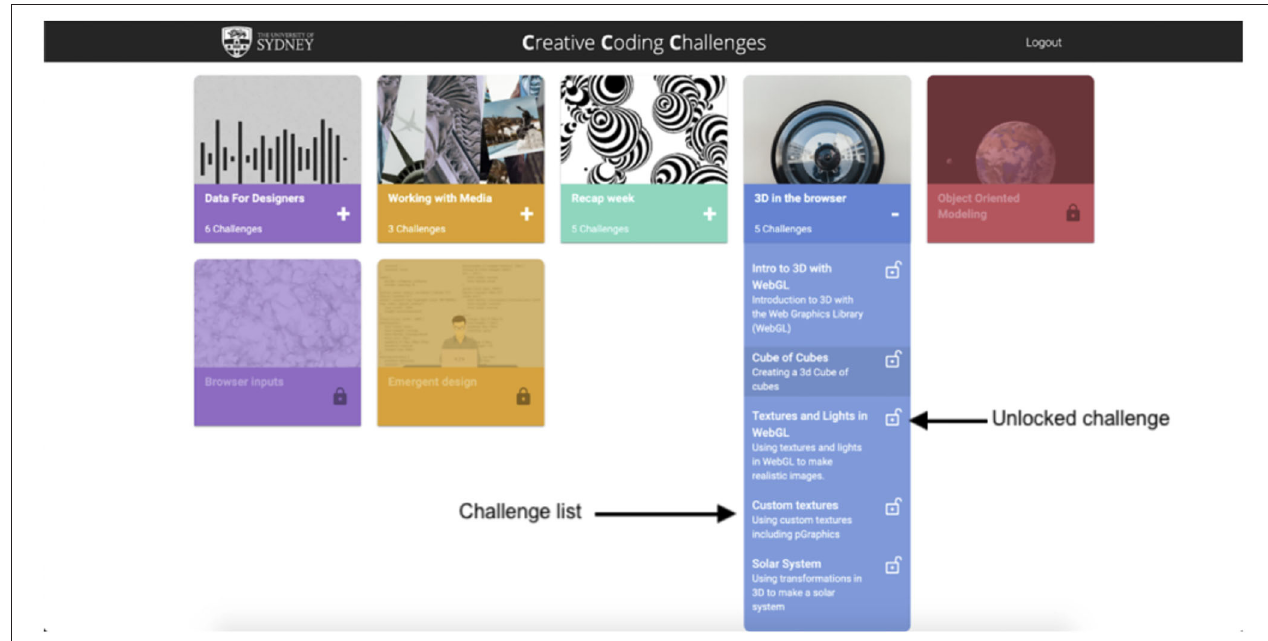
FIGURE 3 | The second version of the CCCs platform interface, showing challenges grouped into “modules,” each corresponding to a week of the